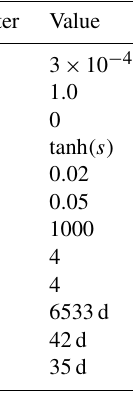
Table 1. Metaparameters